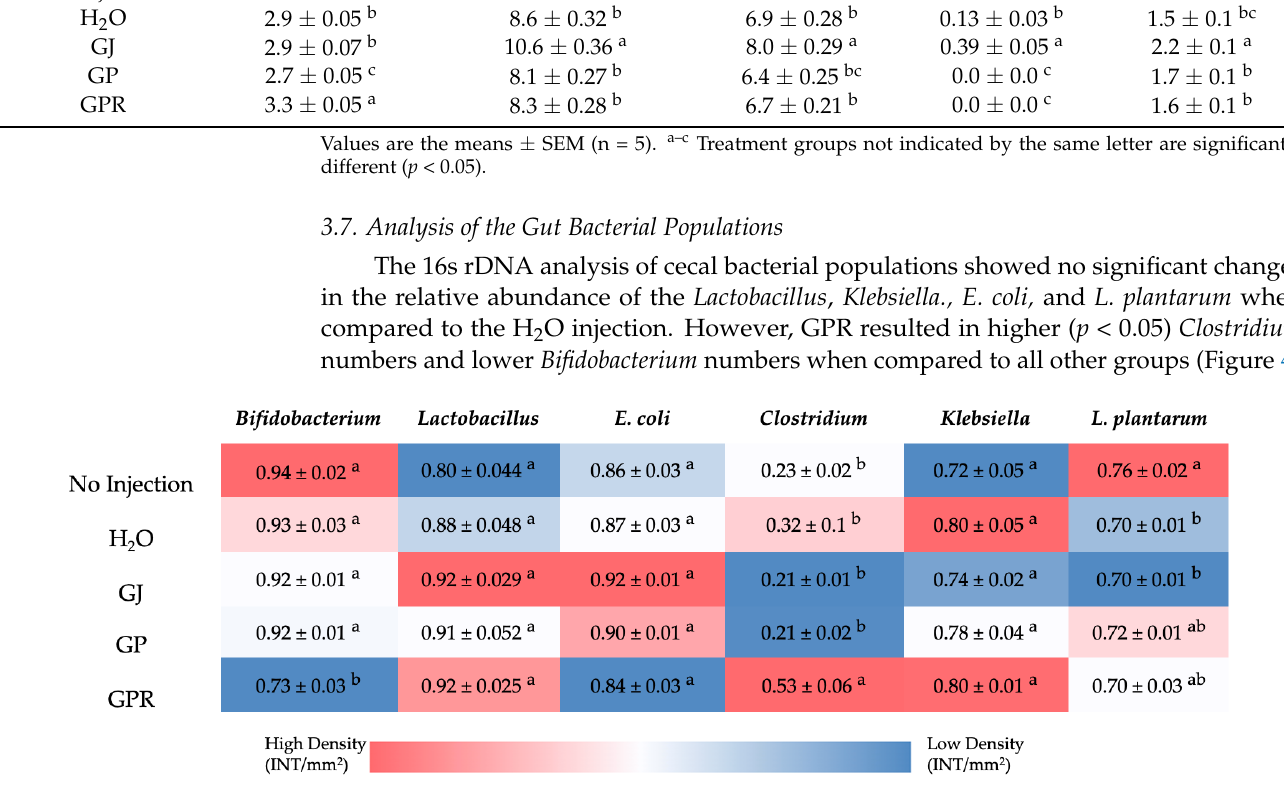
Figure 4. Heatmap showing the difference in cecal bacterial population abundances following intra-amniotic administration of grape juice (GJ), pomace (GP), and puree (GPR). Values are the means ± standard error means (n = 5); Values followed by a different letter indicate statistically significant differences assessed by ANOVA followed by Duncan posthoc test.